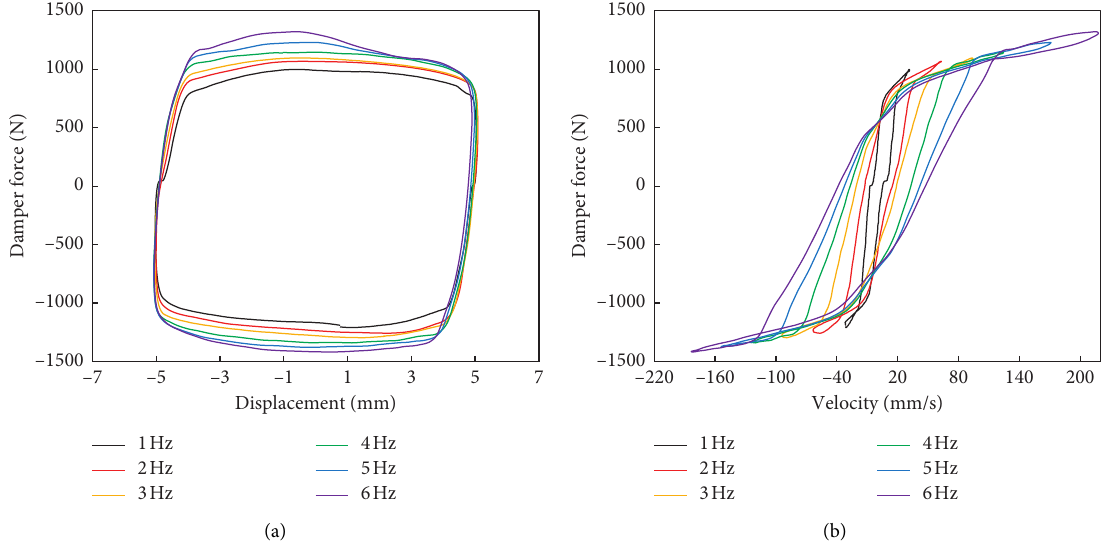
Figure 4: Mechanical properties of different frequencies, current � 0.8 A, and amplitude � 5 mm. (a) Damper force-displacement. (b) Damper